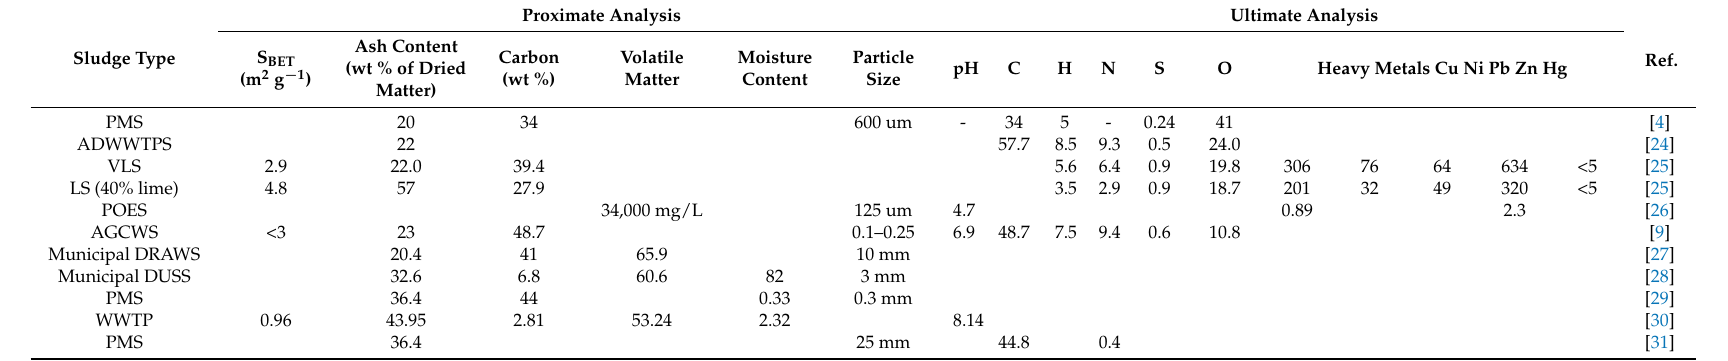
Table 1. Physicochemical characteristics of raw sludge used in production of